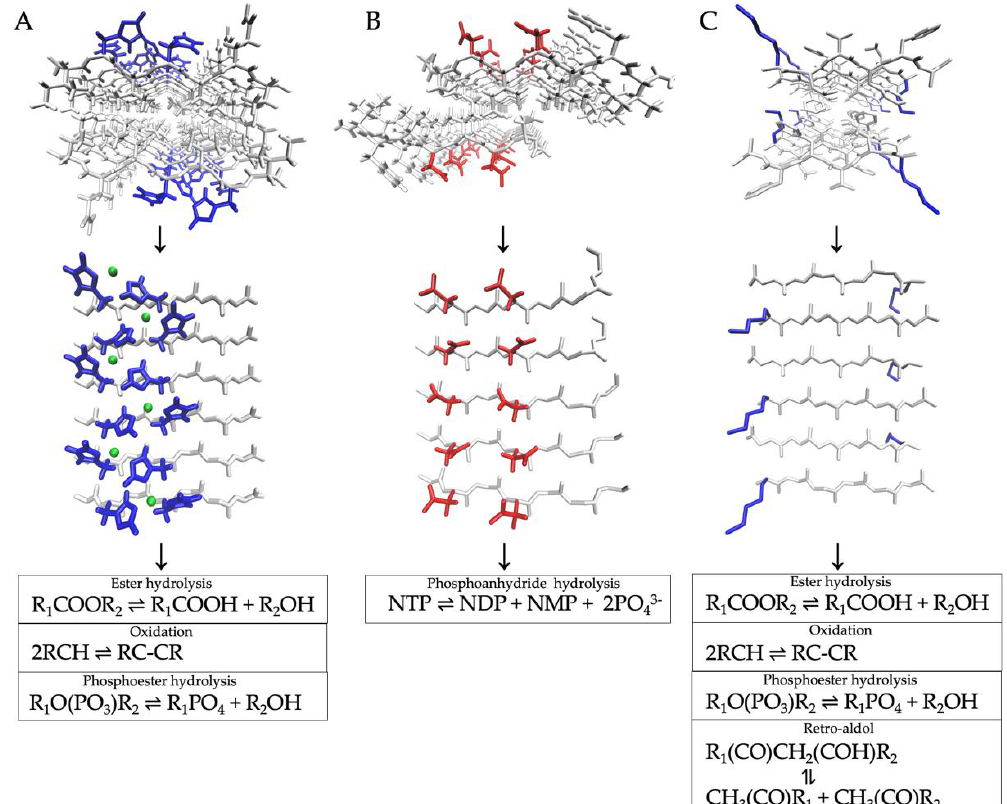
Figure 2. Three-dimensional structures of representative catalytic amyloids along with their catalyzed reactions. The amyloid assembly is shown in full-atomic front view and from a surface perspective in which the catalytically active and non-active residues are highlighted in blue/red and white, respectively. ( A ) Structure of peptide IHIHIQI in the amyloid state obtained by NMR and computational approaches (pdb code 5UGK) [43]. Catalytic histidines are highlighted in blue in coordination bonding with Zn 2+ ions (in green). ( B ) A computational model of self-assembled peptide SDIDVFI is shown with its active aspartate residues (in red) [39]. ( C ) Crystal structure of an amyloid formed by peptide KLVFFA obtained by X-ray diffraction and NMR analyses [45]. Peptides derived from this sequence can self-assemble into amyloids with different catalytic activities, in which lysine (in blue) or similarly basic residues are essential for activity.